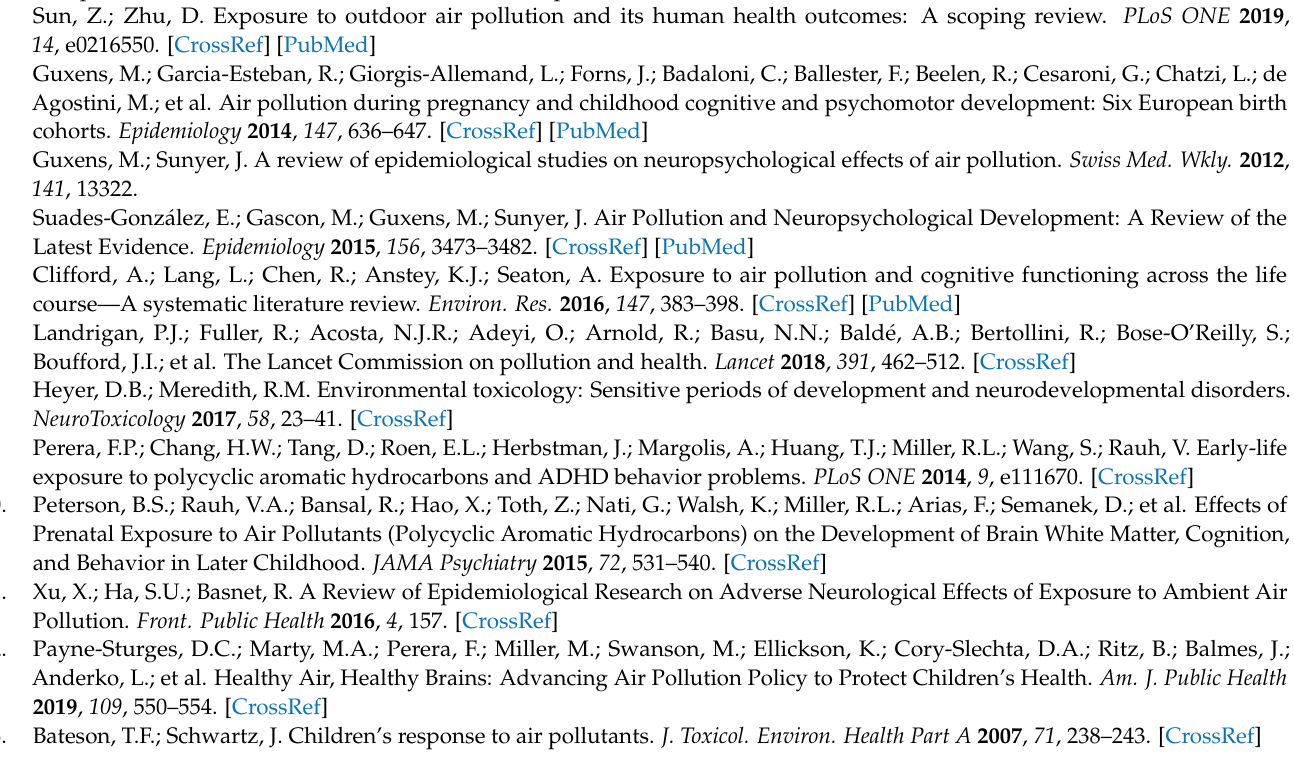
Table S1a: Full coefficients estimated by ME model, relative 95% CI, and p -value for Motor, Adaptive, and Socio-emotional Score. Table S1b: Full coefficients estimated by ME model, relative 95% CI, and p -value for Cognitive, Communicative, and General